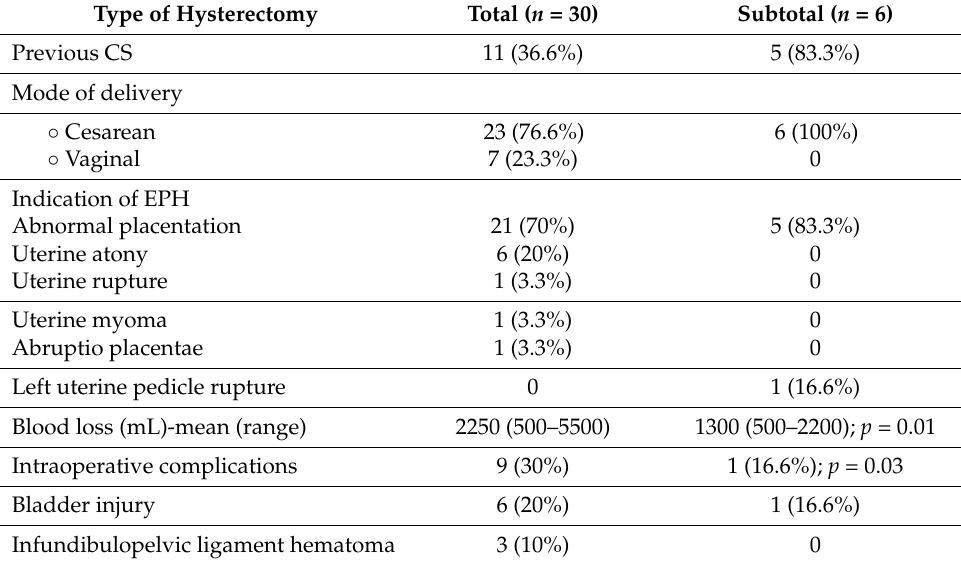
Table 4. Comparison of total vs. subtotal emergency peripartum